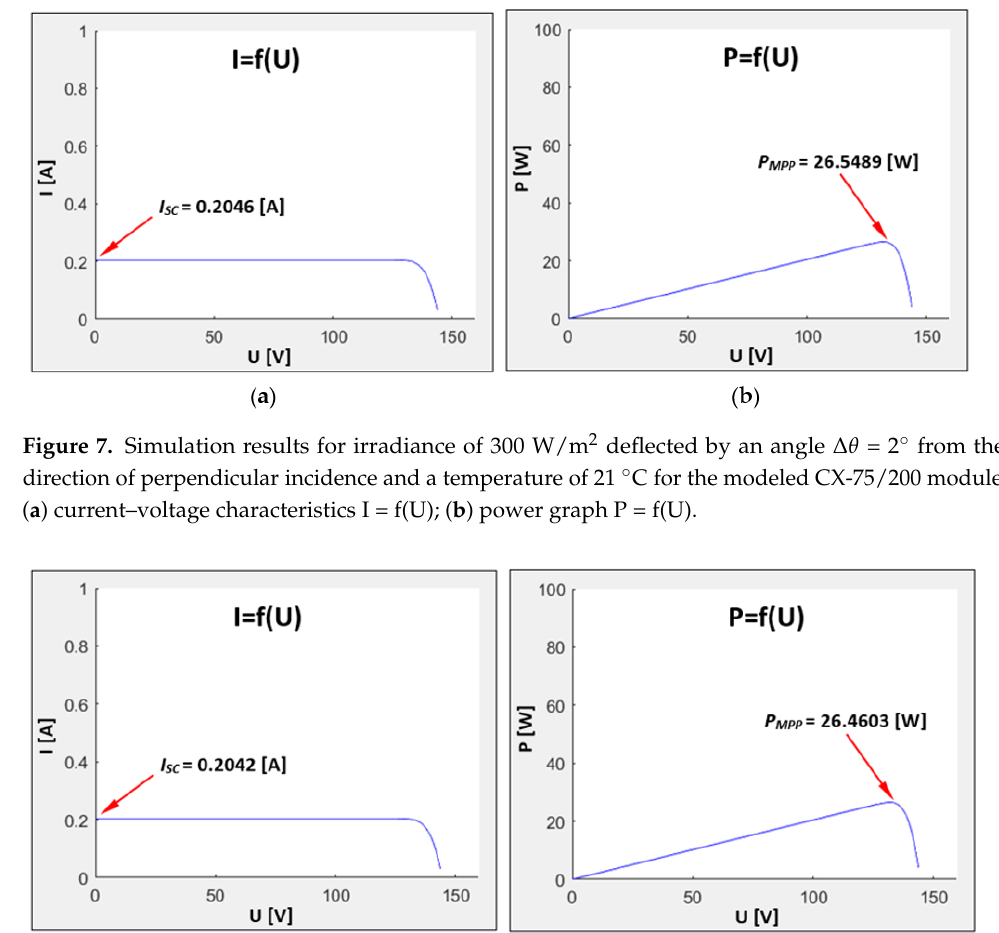
Figure 6. Simulation results for irradiance 300 W/m 2 and temperature 21 °C for modeled CX-